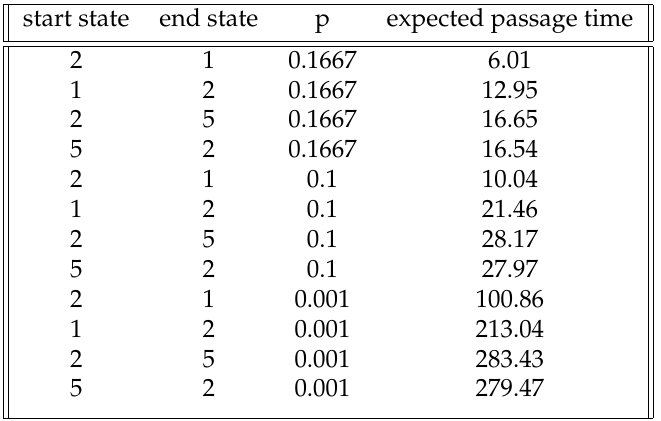
Table 1. A table to represent the effect of changing the value of parameter p on expected passage time from one state to another under square small cell